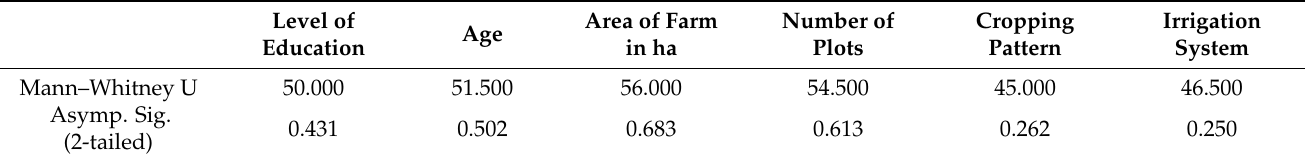
Table 3. Relation between acceptance of the IAS and farmers’ profile parameters.